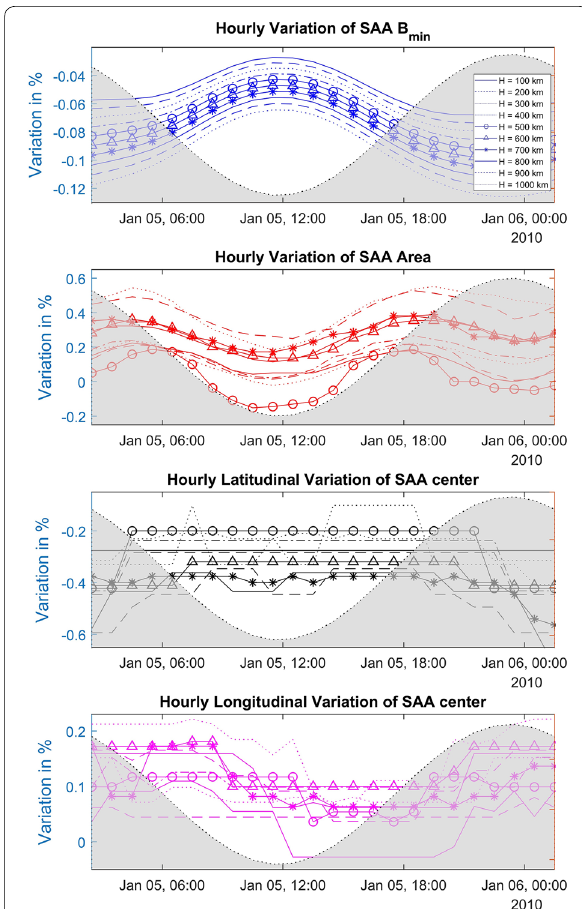
Fig. 10 SAA hourly variations. Diurnal variation of the SAA variables: the area, the B min , the latitudinal and longitudinal center movements with respect to altitude